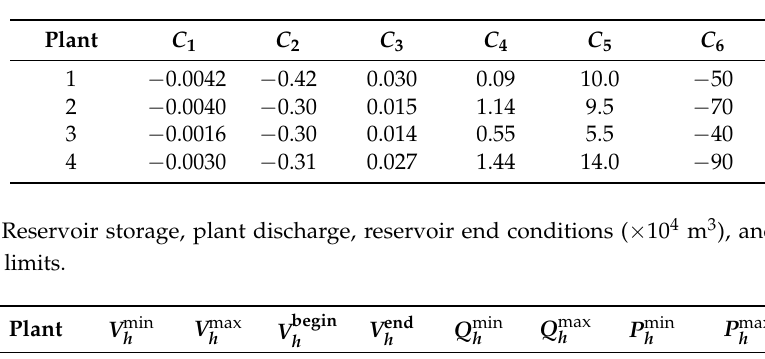
Table A2. Hydro power generation coefficients.